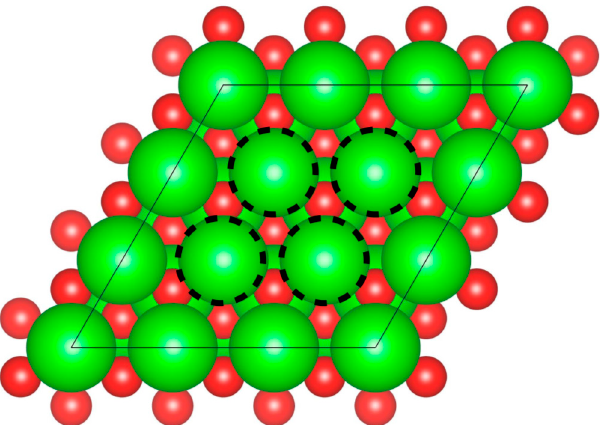
Figure 11. Top view of a 3 × 3 Zr-terminated (111) surface of cubic ZrO 2 . The large green spheres represent Zr atoms, and the small red spheres represent oxygen atoms. The dashed black circles represent the four Zr atoms that were removed to create a depression in the surface.